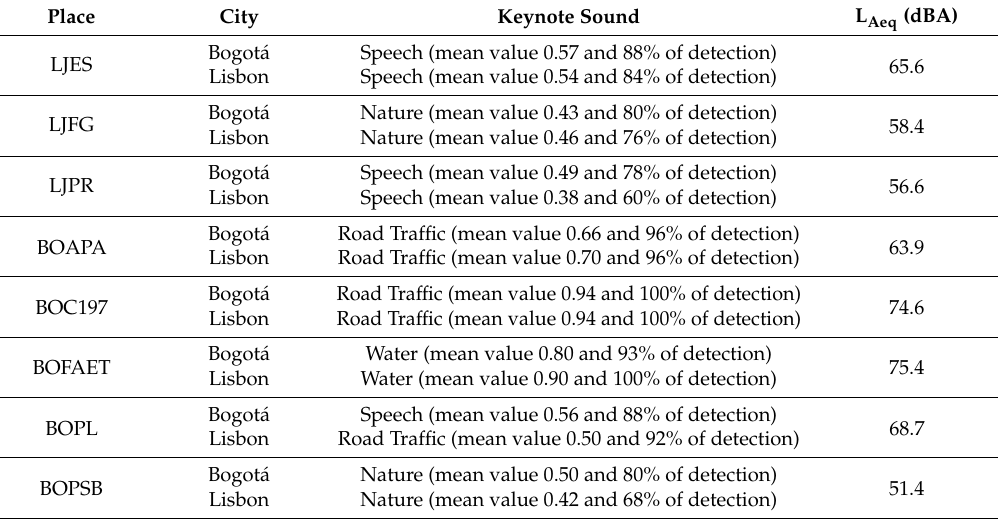
Table 1. Keynote sound and L Aeq of the acoustic environments in